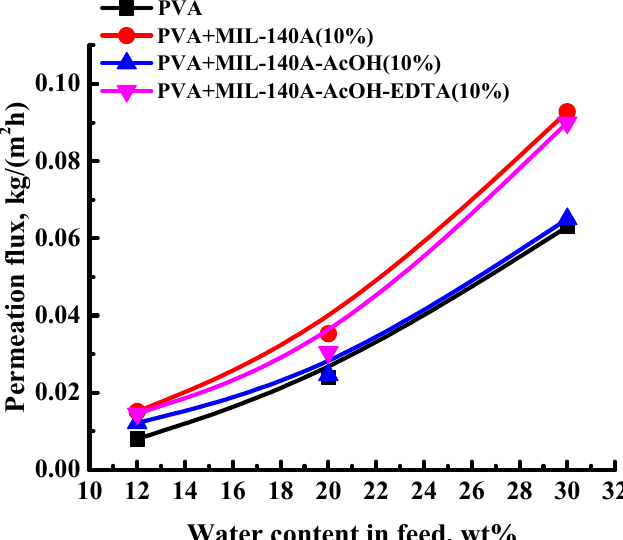
Figure 2. The dependence of the permeation flux on the water content in the feed for the uncross- linked PVA and PVA/Zr-MOFs(10%) membranes in pervaporation separation of water/isopropanol mixtures (12, 20, and 30 wt% water) at 22 °C. Water content in the permeate for all uncross-linked PVA and PVA/Zr-MOFs(10%) membranes was 99.9 wt%.